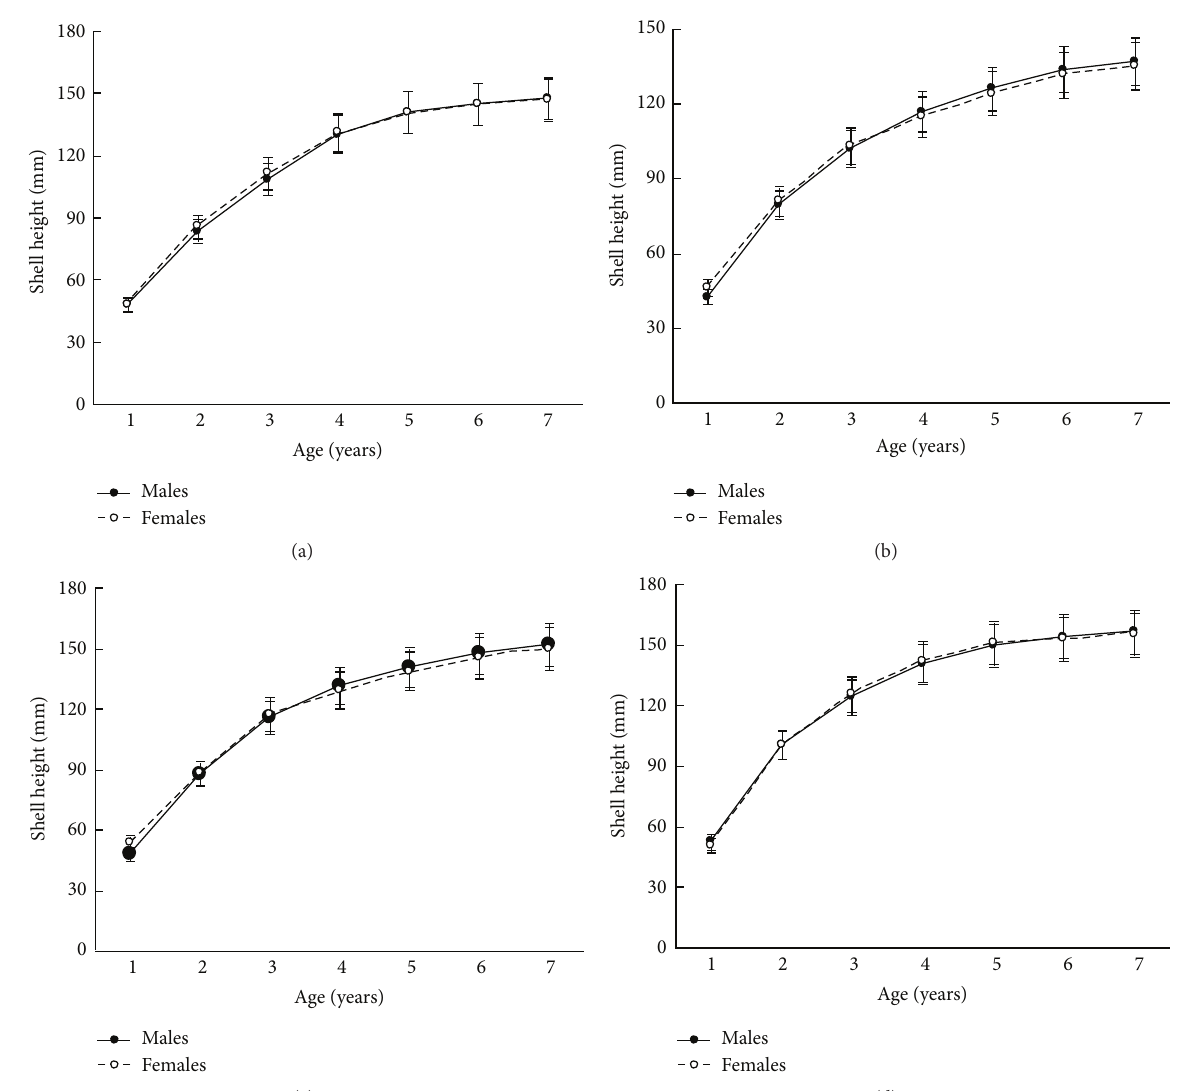
Figure 3: Patinopecten yessoensis . Shell height growth of 7-year-old males and females from (a) Melkovodnaya Bay, (b) Ozero Vtoroe Bay, (c) Vityaz Bay, and (d) Zapadnaya Bay of Furugalm Island. Data are mean ± SE.